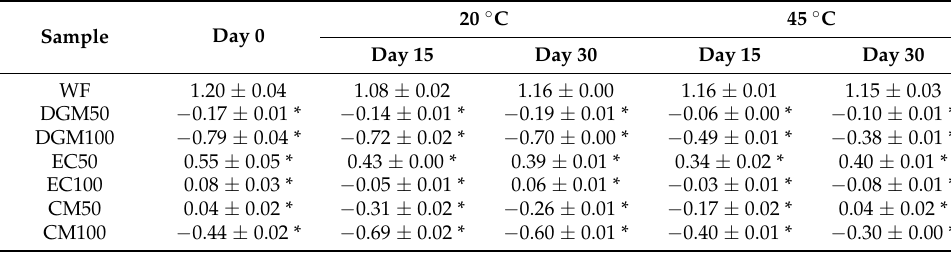
Table 7. Effect of addition of non-encapsulated (DGM), encapsulated (EC) and color-masked (CM) defatted Nannochloropsis oceanica to wheat flour (WF, control) on color coordinate a 1 .